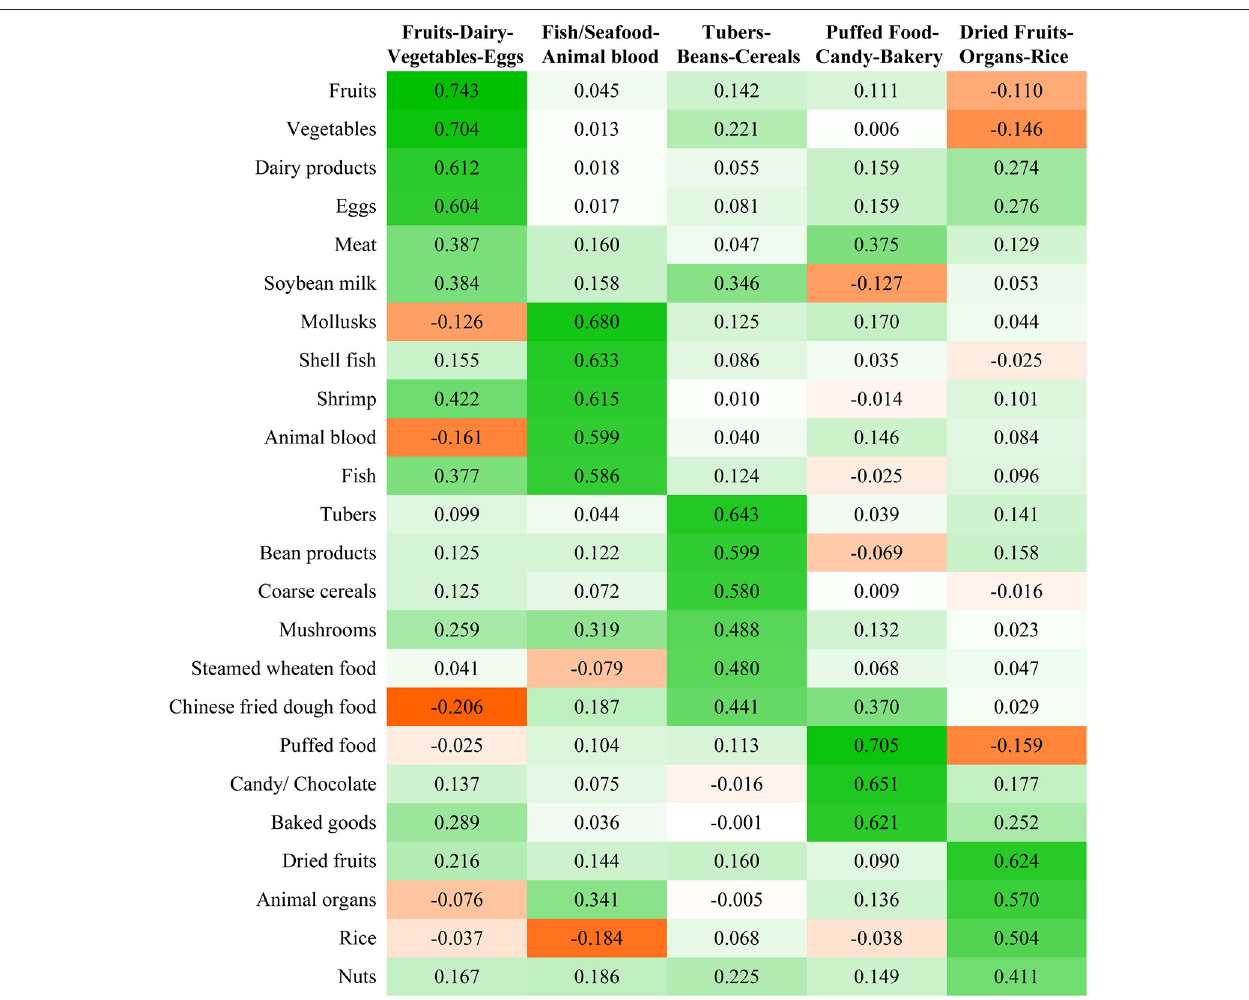
p < 0.2 were adjusted in final models (57), as shown in Supplementary Table 2